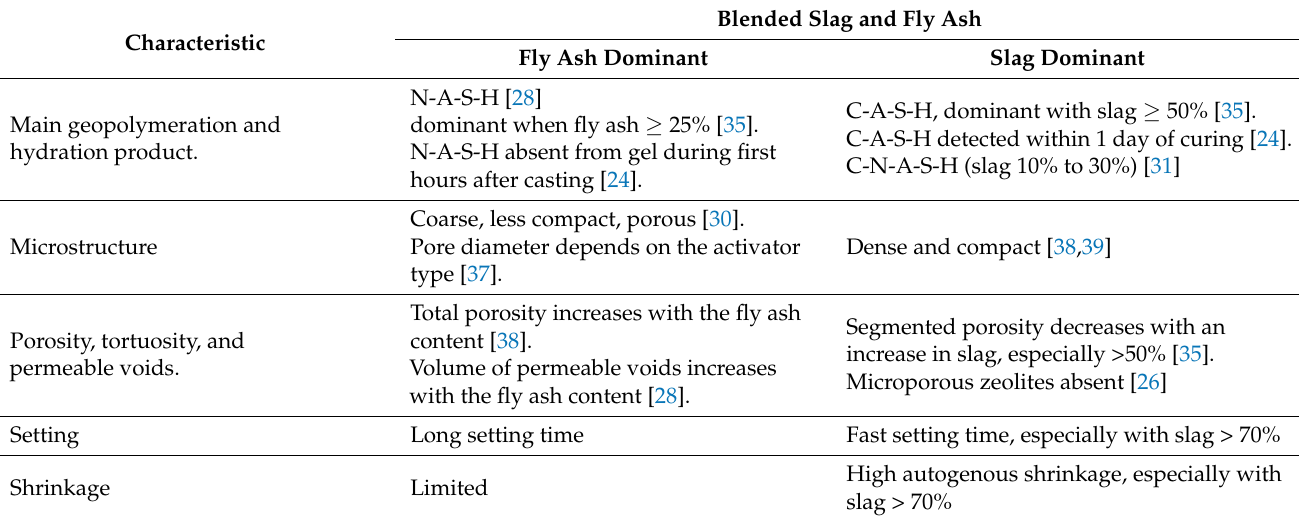
Table 1. Geopolymerization products of alkali-activated slag and fly ash